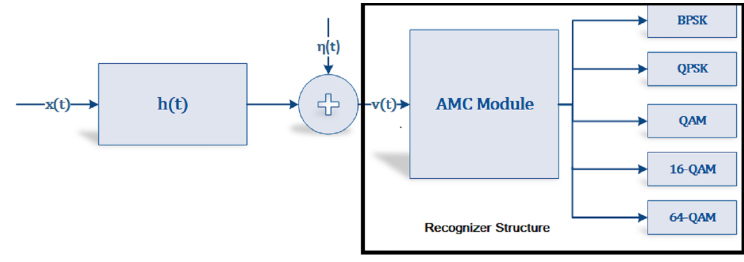
Figure 1. Proposed system